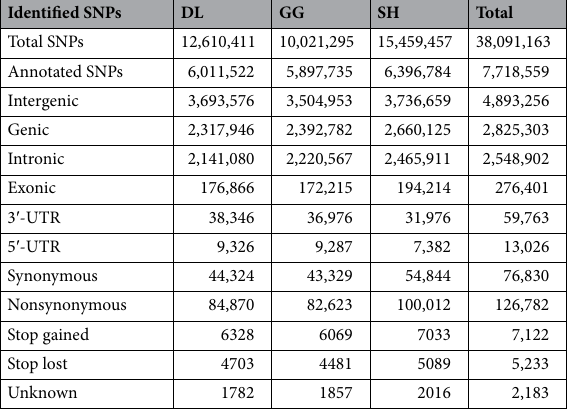
Table 1. Summary of SNP statistical information in Amur ide ecotypes.